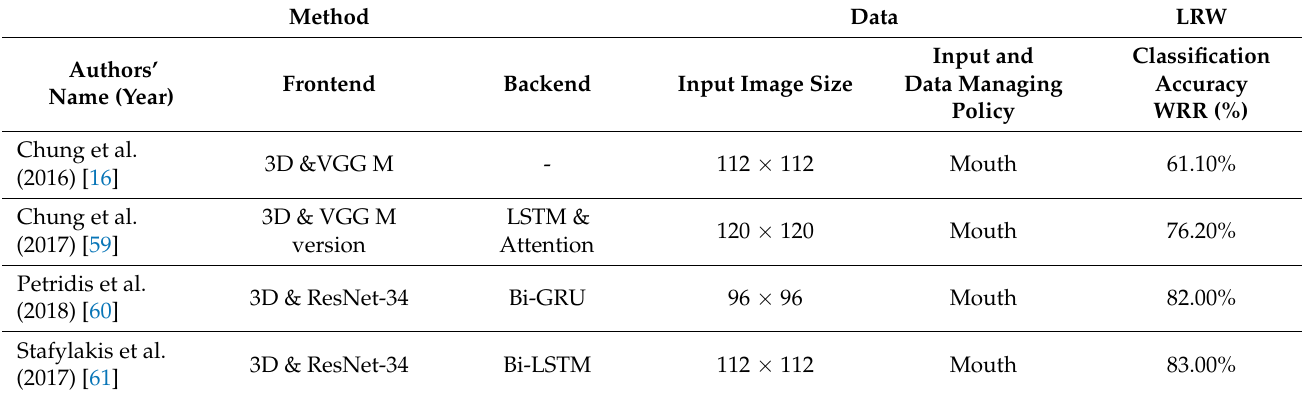
Table 3. Summary of the state-of-the-art results using the LRW-500 dataset.